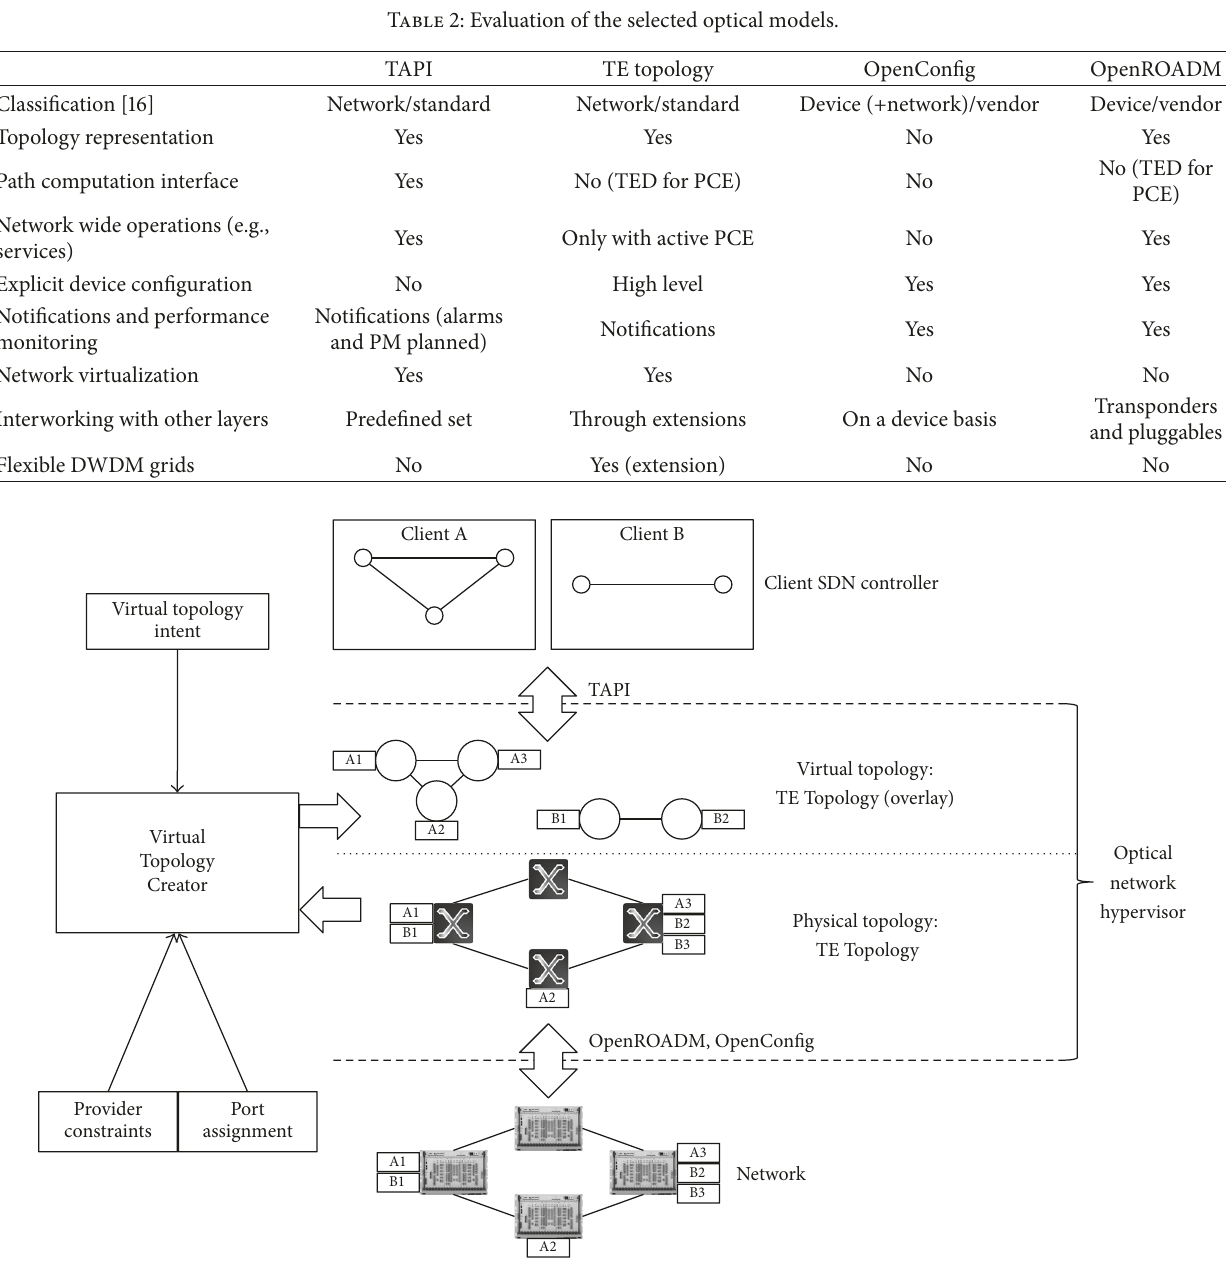
Figure 3: Generic optical network hypervisor architecture with a virtual topology intent interface (lhs) and the model assignment (rhs).